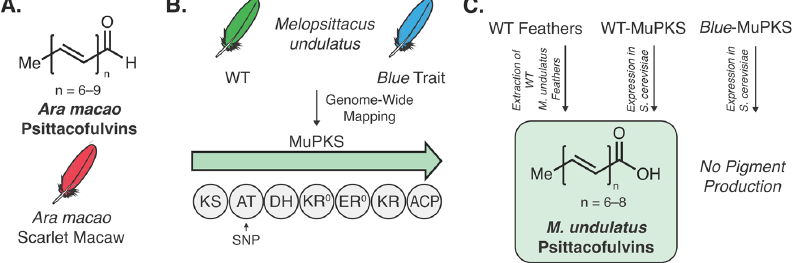
Figure 6. Polyene natural products and their role in pigmentation in birds. ( A ) Psittacofulvins isolated from the scarlet macaw. ( B ) WT feathers in Melopsittacus undulatus are green. The blue trait was mapped to a single ‐ nucleotide polymorphism (SNP) located within the MuPKS. ( C ) Heterologous expression of MuPKS in yeast led to the production of the same polyene pigments found within WT feathers. Heterologous expression of the MuPKS with the blue trait SNP led to no pigment production